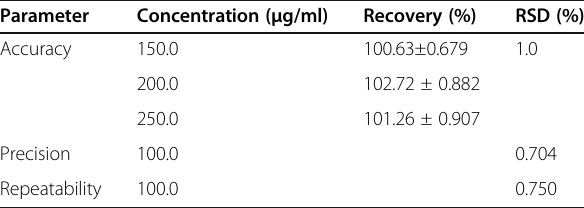
Table 2 Trueness, repeatability, and precision result in method